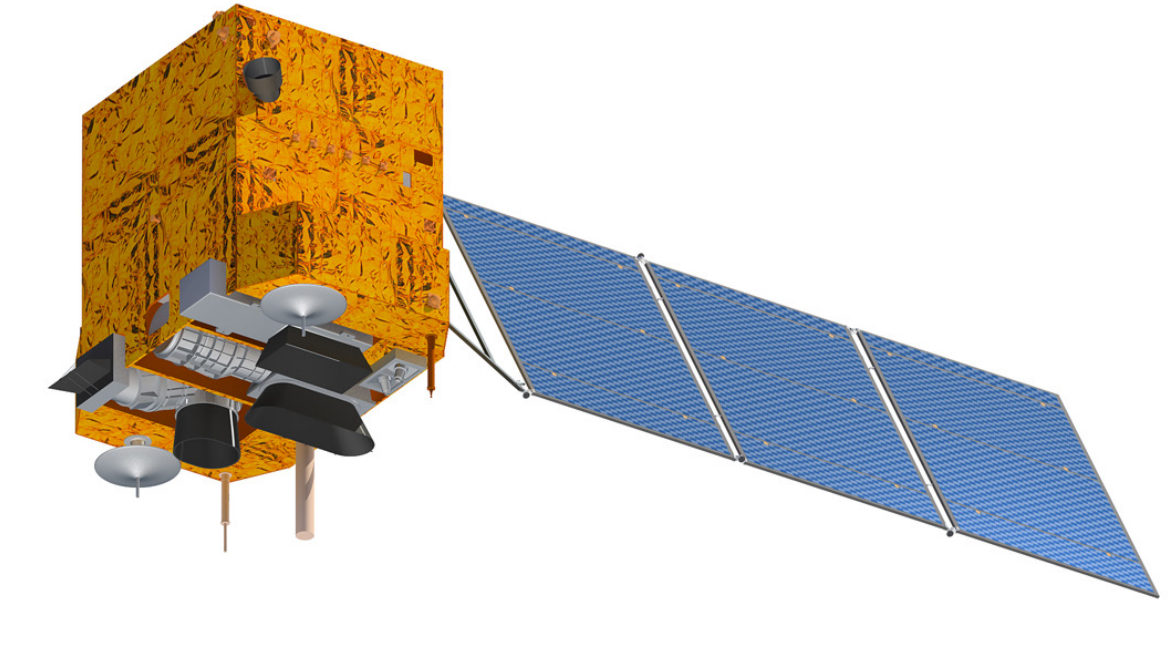
Figure 1. CBERS-4 satellite illustration (INPE